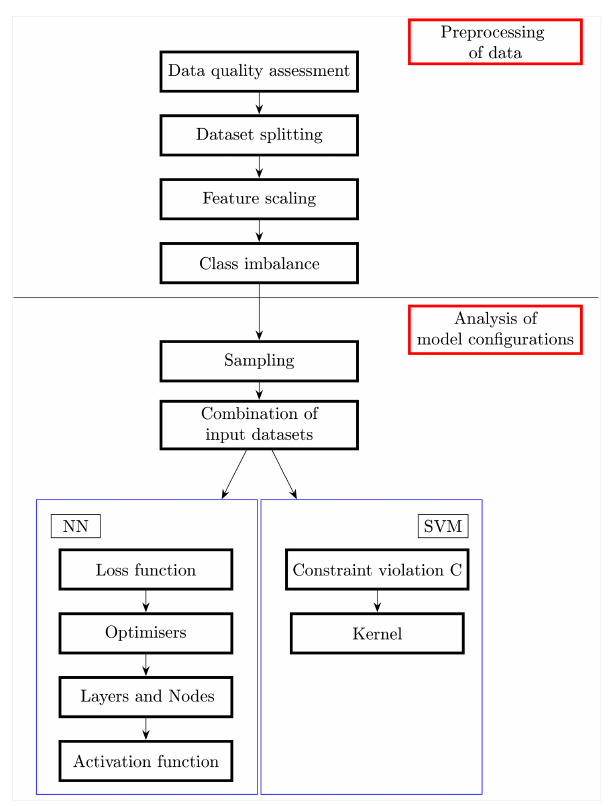
Figure 4. Framework used to analyse the domain of possible model